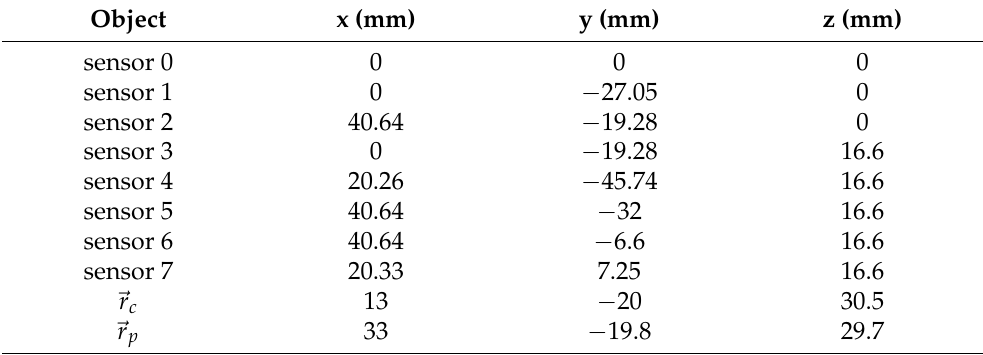
Table 3. Co-ordinates of the sensors. The last two lines report the central and peripheral target positions (determined by the tracker) considered in the analyses of this